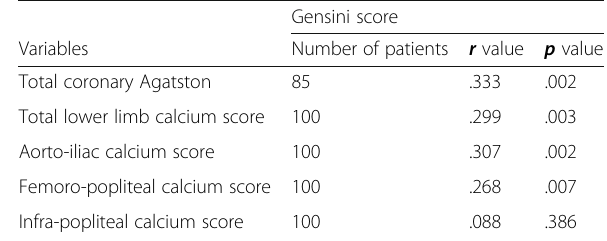
Table 2 Clinical presentation of studied patients Clinical presentation